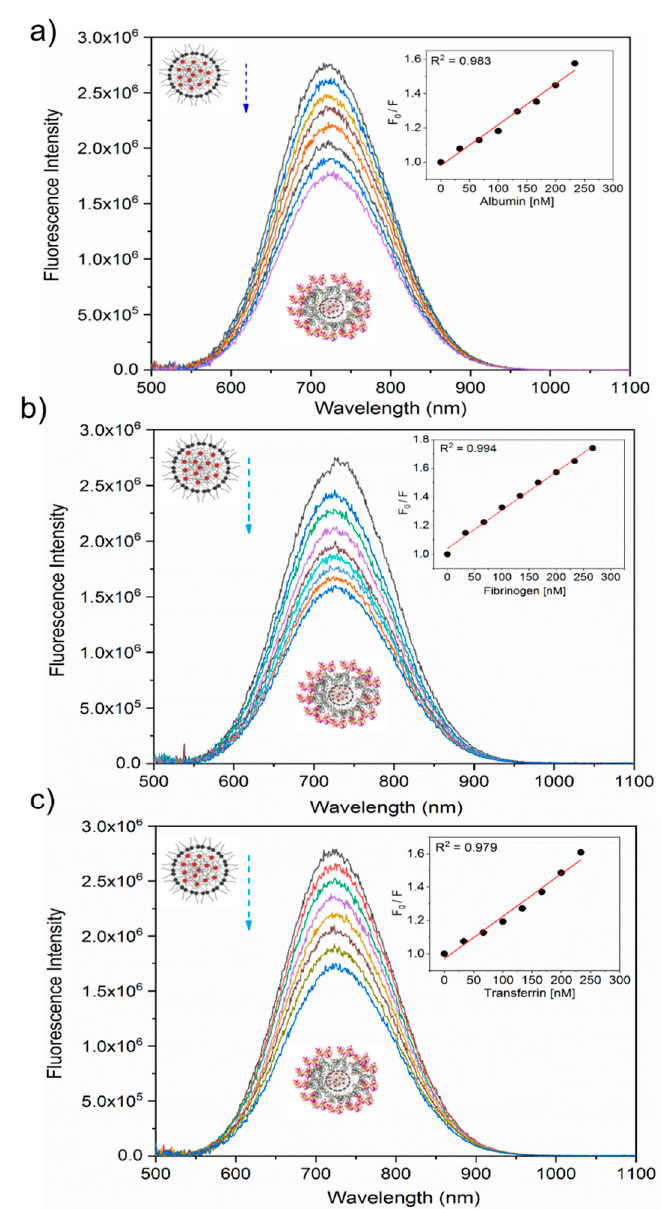
Figure 4. Photoluminescence (PL) spectra of SiQDs/F127 nanoparticles with the incremental addition of plasma proteins. Fluorescence emission spectra and its corresponding Stern–Volmer plots of SiQDs/F127 nanoparticles are shown in the absence and presence of human serum albumin ( a ), fibrinogen ( b ), and transferrin ( c ).